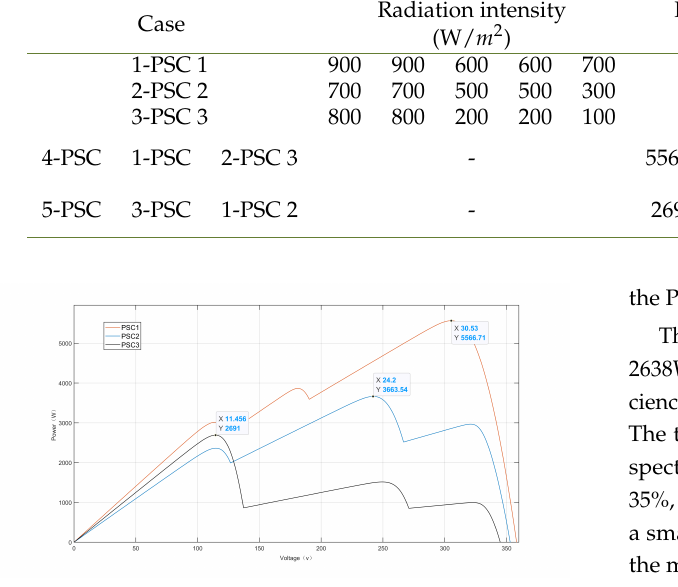
Fig. 5. P-V curves of photovoltaic arrays under different radiation